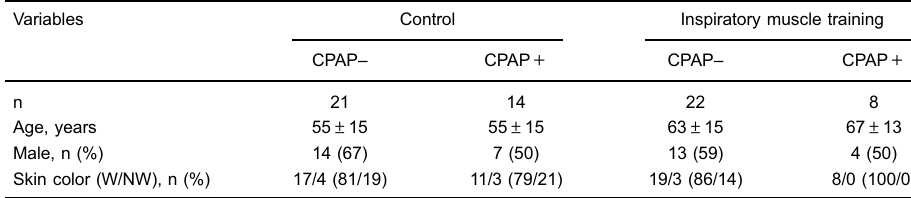
Table 1. General characteristics of baseline